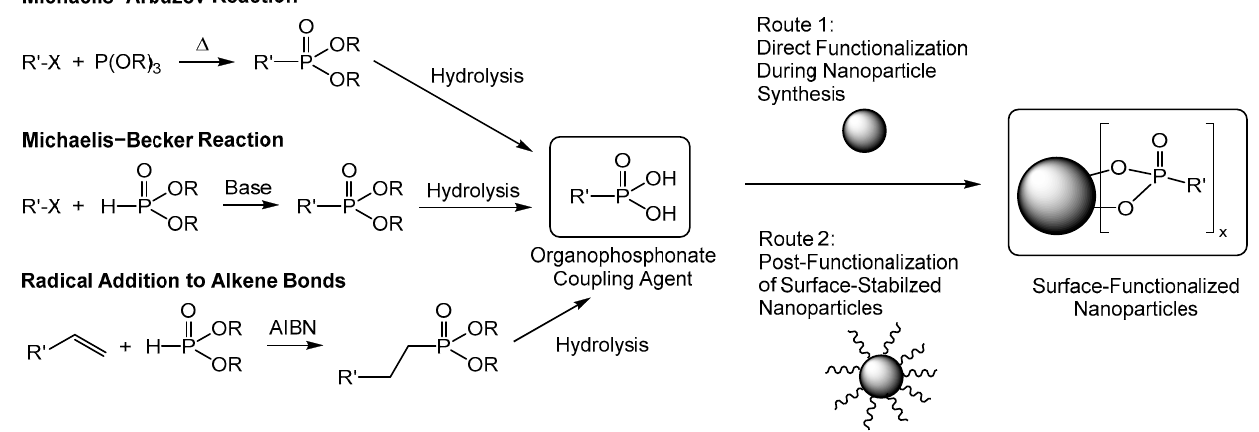
Figure 1. Synthesis of organophosphonate coupling agents and their attachment to the surface of metal oxide nanoparticles.